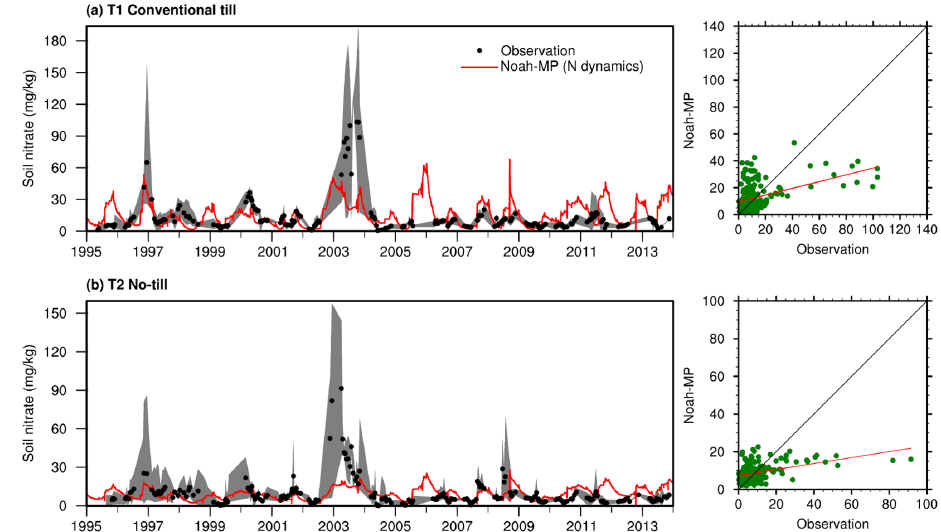
Figure 4. Observed and model-simulated nitrate leaching from bottom of soil profile from 1995 to 2013 for (a) treatment 1 – cropland with conventional tillage – and (b) treatment 2: cropland without tillage. The grey shaded area shows the observational ranges from up to six replicates for each